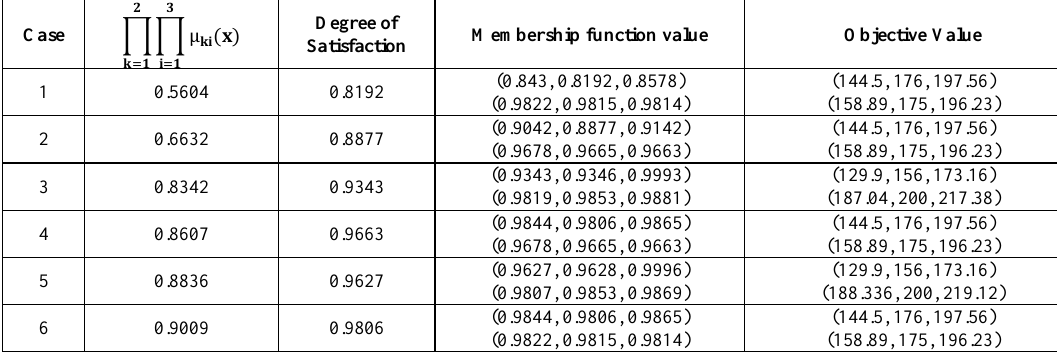
Table 3. Summary results for α = 0.1